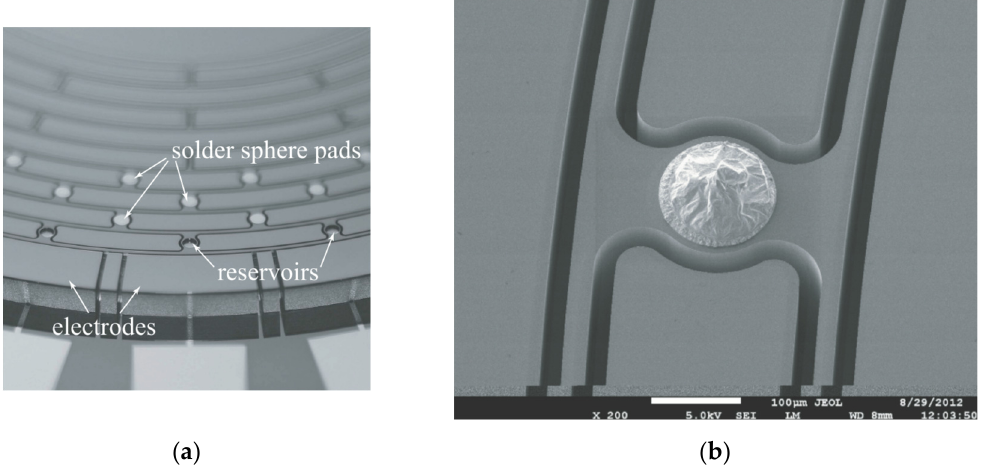
Figure 3. Schematic diagram of the structure of proposed mass perturbation tuning technology; ( a ) Structural diagram; ( b ) Reflow solder ball on the gold pad of the resonator